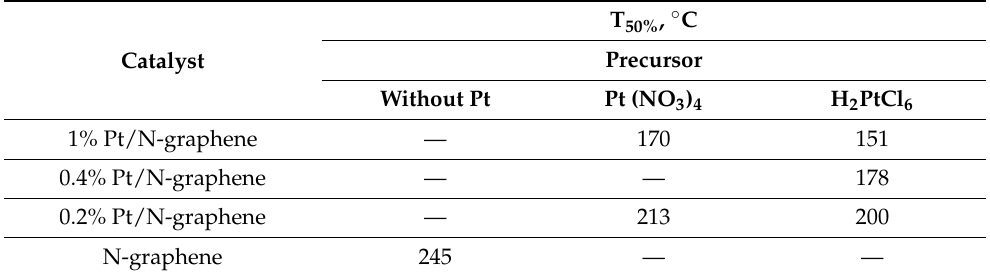
Table 3. Temperature of 50% FA conversion over the studied catalysts and the support.